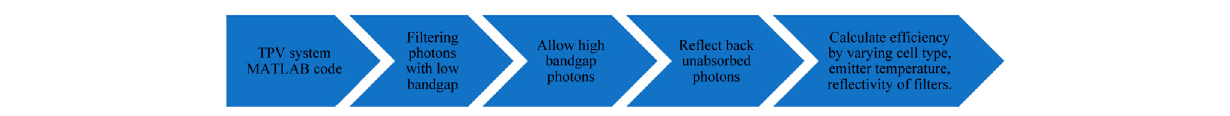
FIGURE 4 | Flow chart representing the followed met hodology which represents the mentioned procedure in the form of a fl ow chart which explains the TPV system is modeled using MATLAB which encounter the variables that stops the low bandgap photons reaching the front surface of TPV cell then BSR variables re fl ects the unabsorbed photons back to the front side of the TPV